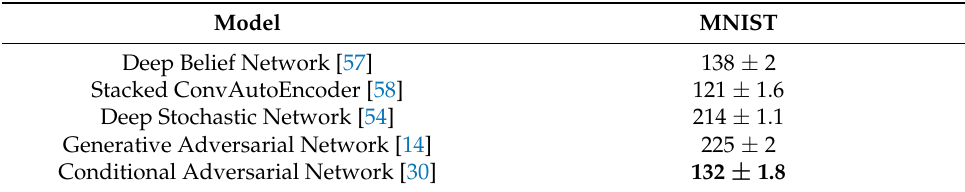
Table 3. Results for different models used over MNIST dataset